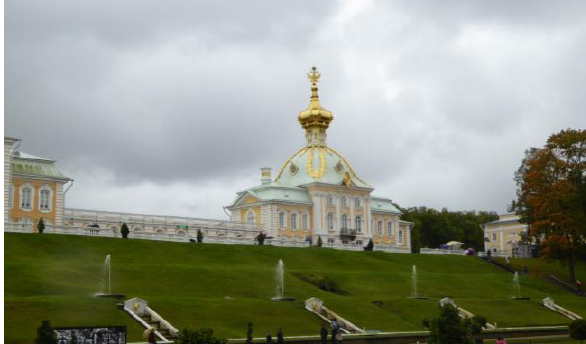
Figure 2. Present day state of cupola and the dome of the Western part of the Grand Palace (photo ©A. Segre,